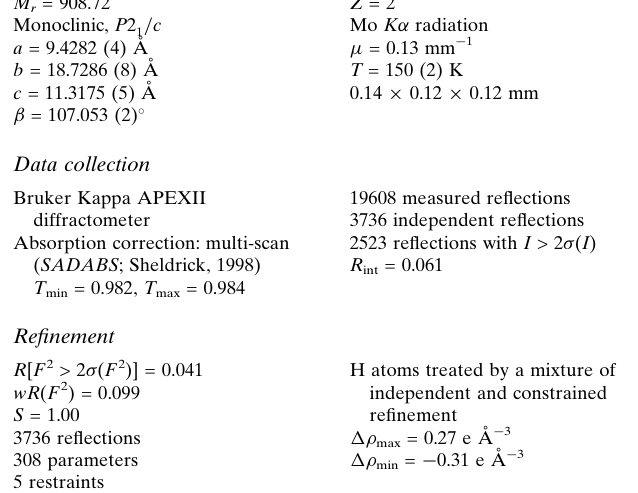
19608 measured reflections 3736 independent reflections